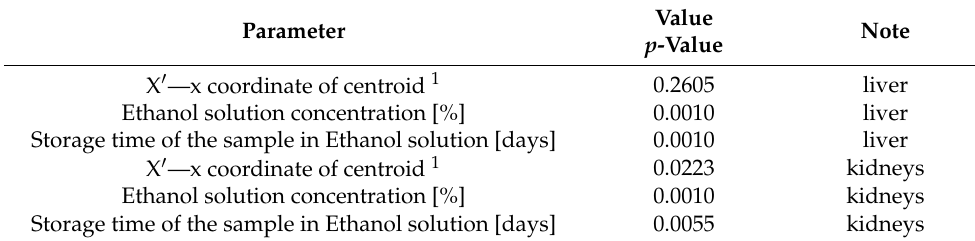
Table 2. Ethanol liver raw data for centroid and Spearman ´ s correlation coefficient